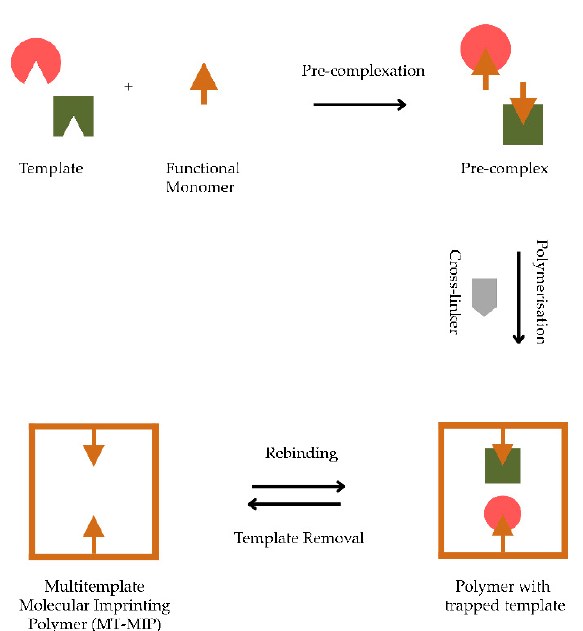
Figure 2. Illustration of the multi-template molecularly imprinted polymer production.